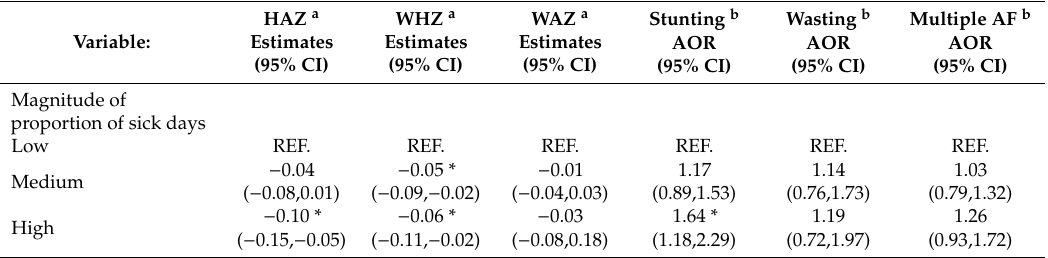
Table 4. The e ff ect of proportion of sick days on nutritional status and z-score changes by calculated adjusted odds ratios (AORs) and fitted estimates (LMER) of mixed-e ff ect